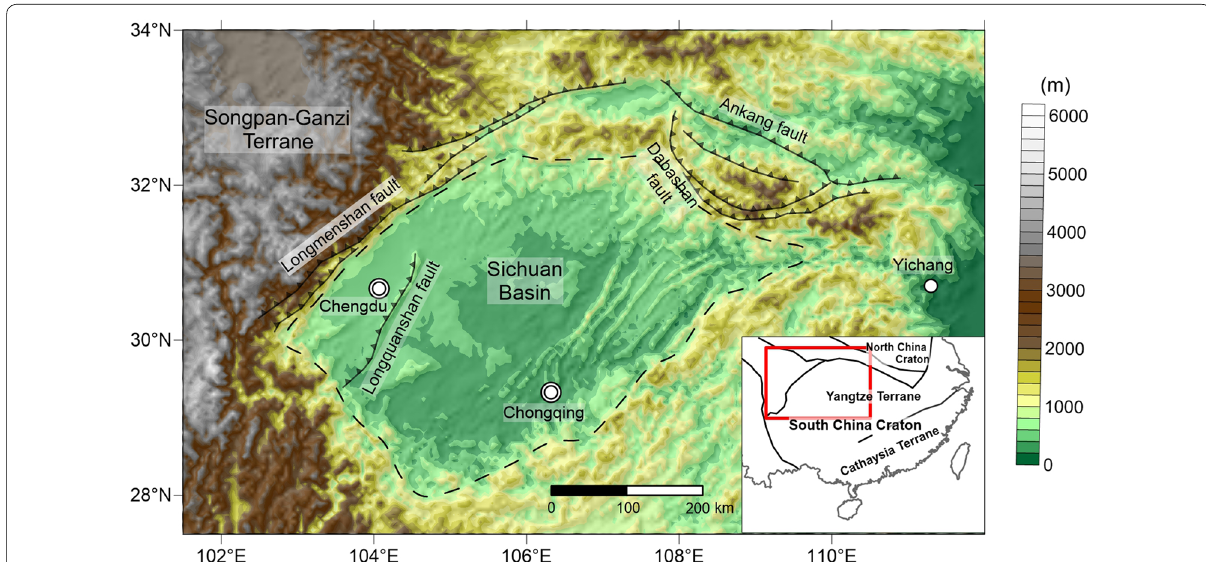
Fig. 1 Topography in Sichuan Basin. The range of our study area is framed by a red rectangle in the simplified tectonic maps of South China at the lower right corner. The main thrust faults in the western and northern Sichuan Basin are marked. The range of the Sichuan Basin is circled by a black dashed